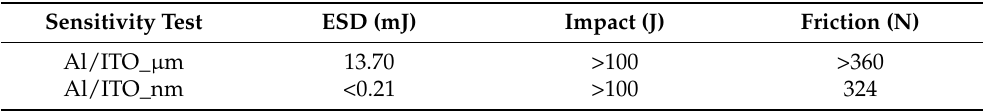
Table 1. Sensitivity thresholds of the Al/ITO thermites (at an equivalence ratio φ of 1.2) with respect to the oxidizer